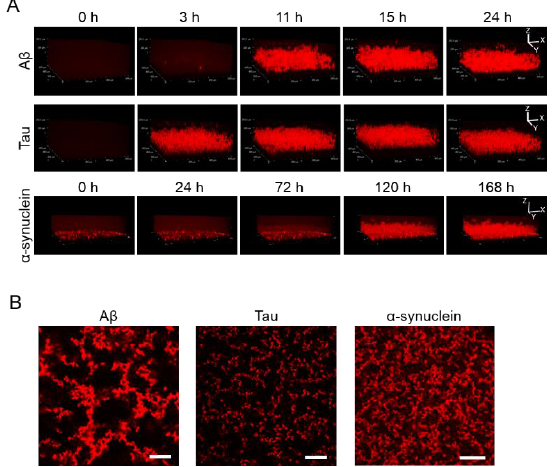
Figure 2. ( A ) 3D observation of the aggregation of Aβ, tau, and α -synuclein. Thirty-micrometer Aβ and 10- µ M tau were incubated for 24 h. Ten-micrometer α -synuclein was incubated for 168 h. Sequential 3D reconstruction images of each time point are represented. ( B ) Image of the slices of aggregation of each protein in panel A. Note that aggregate sizes and densities are different among all three proteins. Scale bar = 100 µm.